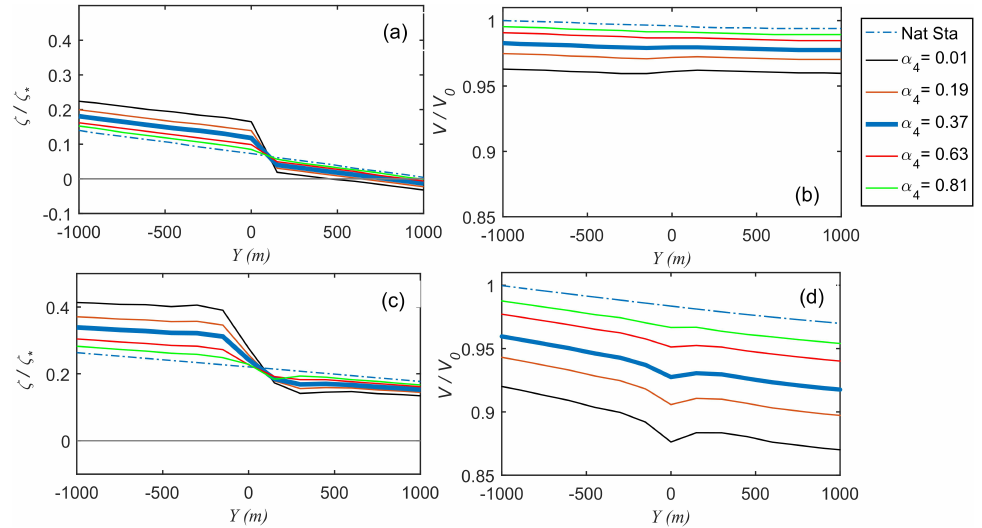
Figure 7. Selected values of normalised water elevation profiles and the Y component of the velocity along the channel centreline obtained with ADI ( a , b ) and TVD ( c , d